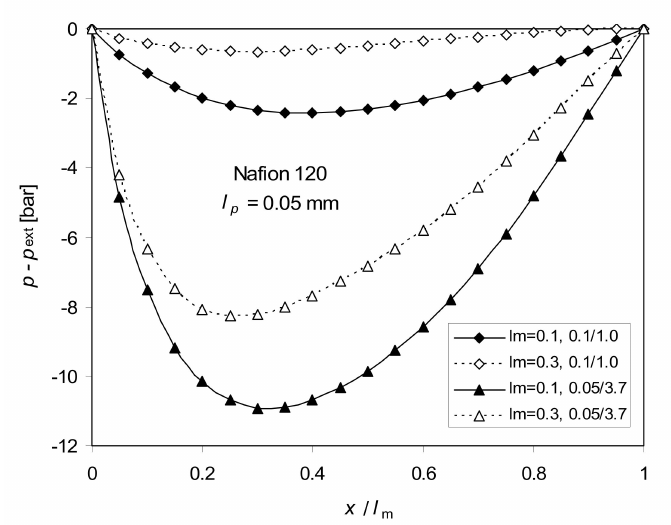
Figure 3. Pressure profile across the membrane calculated from Equation (5) (full ITE) for l m = 0.3 mm and l m = 0.1 mm, for 0.1–1.0 M and 0.05–3.7 M NaCl, T = 298 K. Thickness of the concentration polarization layer l p = 0.05 mm. Thickness of the membrane— l m